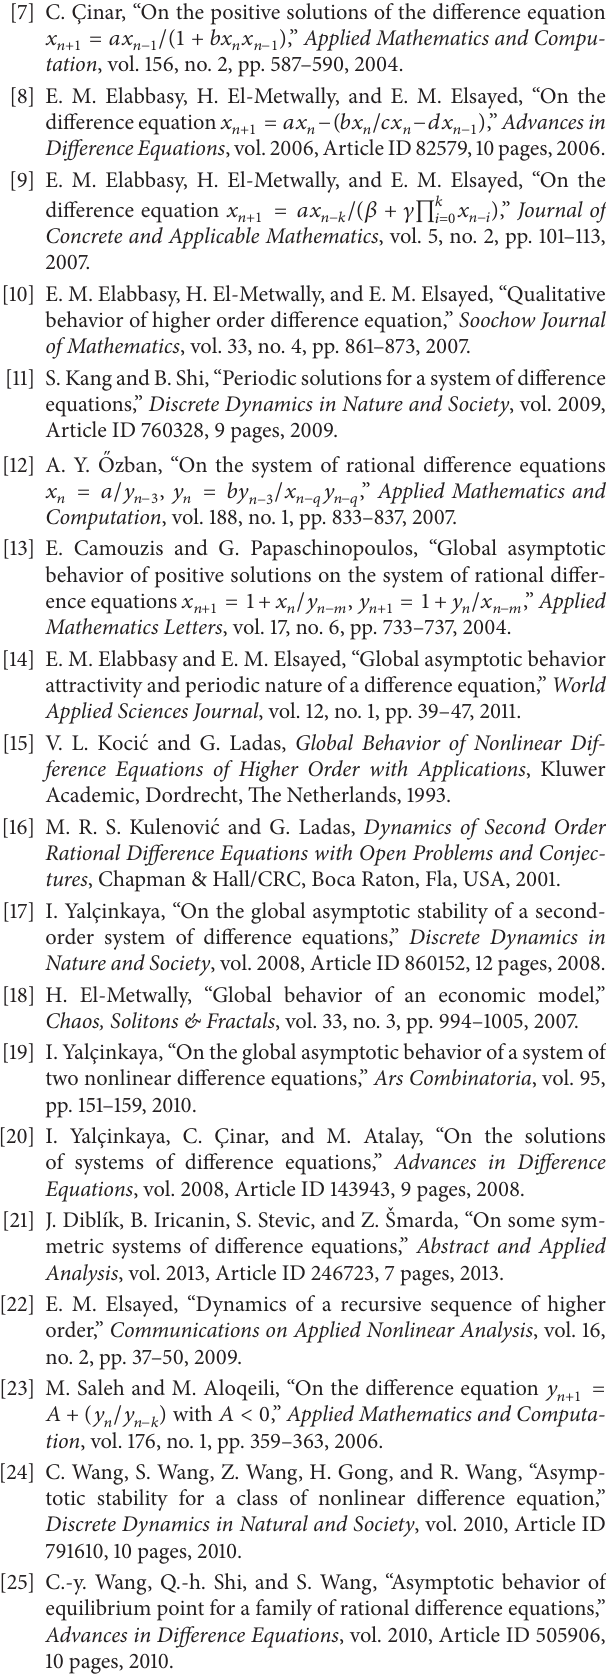
= 𝑥 = 𝑞, 𝑥 = 𝑥 = 𝑥 = 𝑝, 𝑎 = 9, 𝑏 = 5, 𝑐 = −3 −1 −4 −2 0